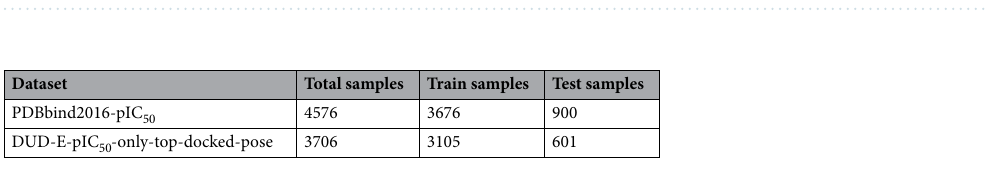
Table 3. Summary of data used for training and testing EBA regression models. a Refer to Table SS5 in the supporting information for detailed dataset splits.